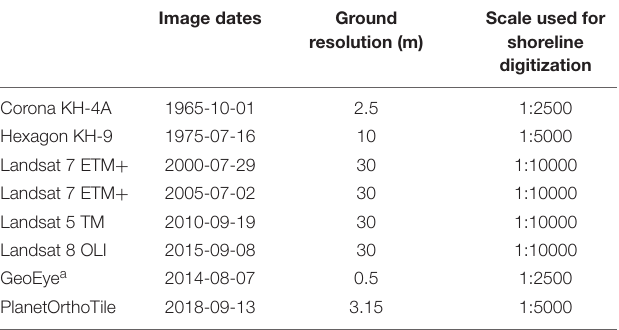
TABLE 1 | Images used for calculation of erosion rates. Image dates Ground Scale used for resolution (m)